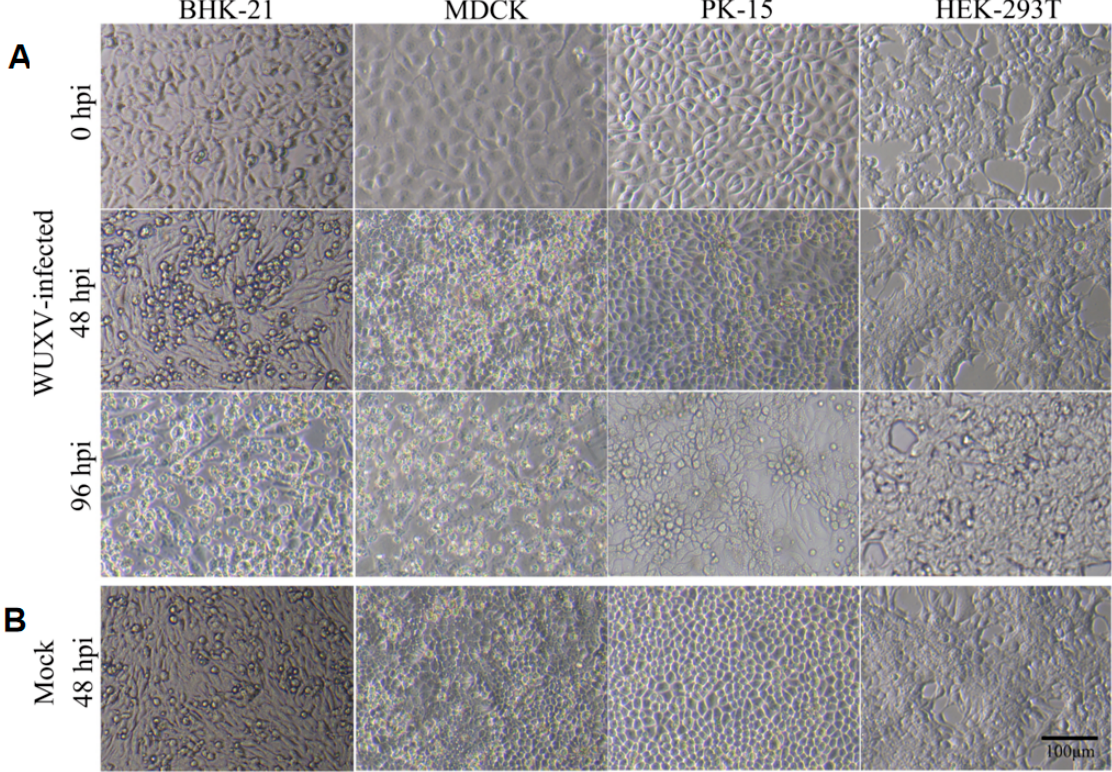
Figure 1. Cytopathic changes observed in cell lines at 0, 48, and 96 hpi. Cells were ( A ) infected with WUXV SXWX1813 ‐ 2 or ( B ) mock infected (48 hpi) at a multiplicity of infection (MOI) of 0.05. Morphological changes were observed using brightfield microcopy; Scale Bar = 100 μ m.